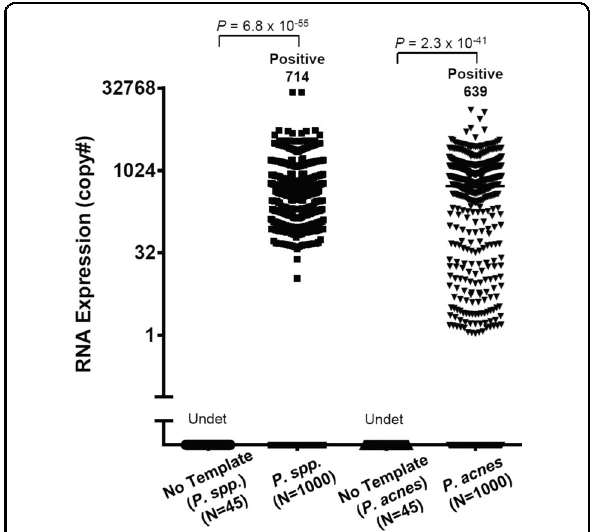
Fig. 1 Detection of P. spp . in human AH specimens. Expression of P. spp . 16S rRNA and a P. acnes -speci fi c gene — PPA_RS04200 (presented as the copy#) in the AH from 1000 human eyes undergoing cataract surgery was quanti fi ed using real-time PCR assays. The P value was calculated using parametric Student ’ s t -test. Undet,